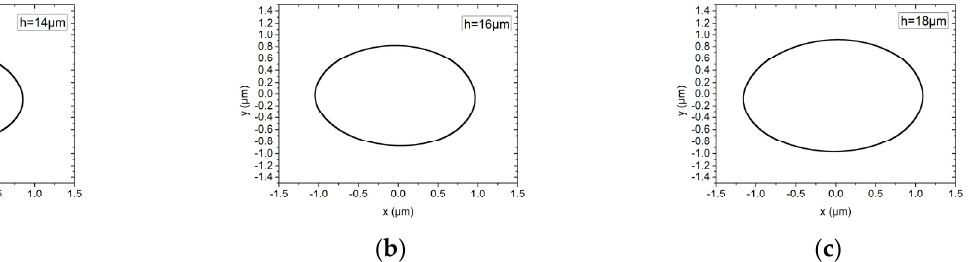
Figure 12. Rotor center trajectory under different gas film thickness under working condition 6 (high speed, dynamic unbalance G0.1). ( a ) Rotor center trajectory ( h = 14 μ m), ( b ) rotor center trajectory ( h = 16 μ m), ( c ) rotor center trajectory ( h = 18 μ m).